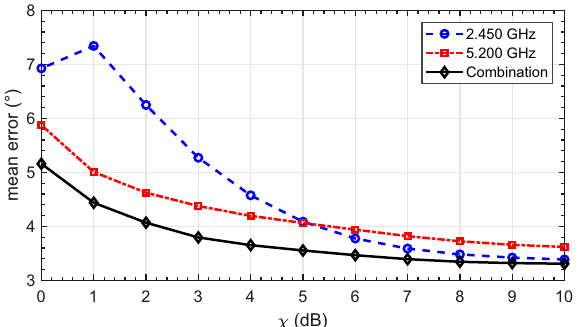
Figure 15. Mean DoA estimation error, synthetic graph for all D values.